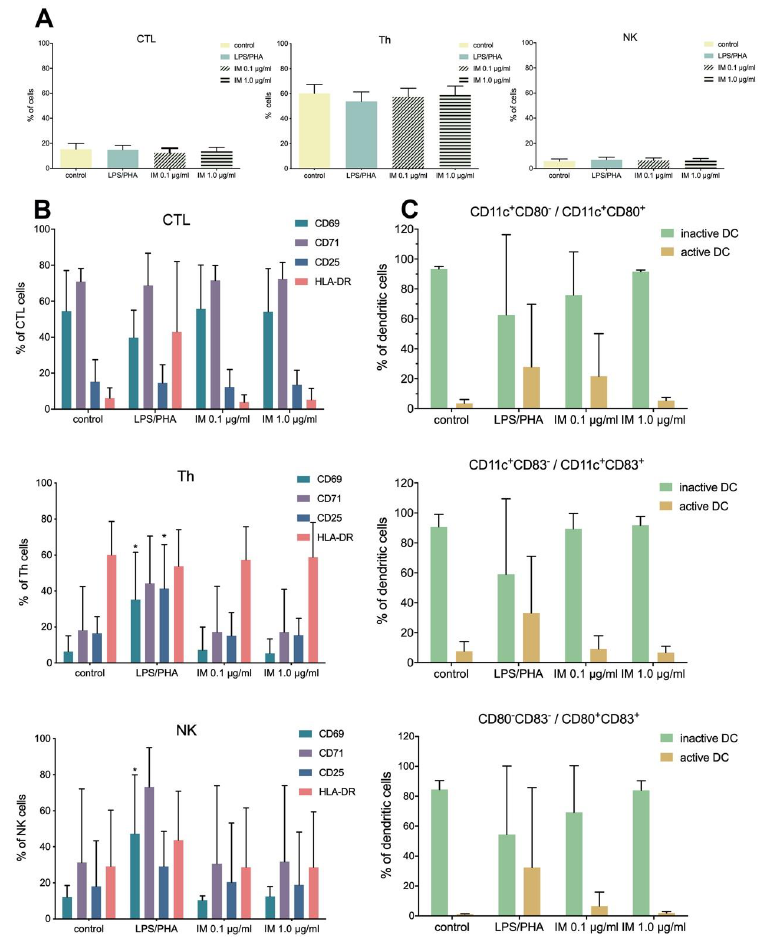
Figure 3. Effect of IM on immune cells activation. ( A ) overall percentage of immune cells subpopulations cytotoxic T lymphocytes (CTL), helper T cells (Th), and natural killer cells (NK), after stimulation with IM (0.1 µg/mL; 1.0 µg/mL). Unstimulated cells were treated as a negative control, while cell cultivated in the presence of LPS/PHA were a positive control. ( B ) percentage of cells expressing activation markers among specific immune cell subpopulations CTL, Th, and NK. ( C ) activation of dendritic cells (DC) subjected to IM, presented as a percentage of cells with active phenotype. The graph shows results from 5 independent experiments. Results are presented as mean with SD. *—statistically significant differences compared to control, Mann–Whitney U test, p < 0.05. All data are presented as percentages due to the application of hospital diagnostic laboratory standards for immune cells analyses.